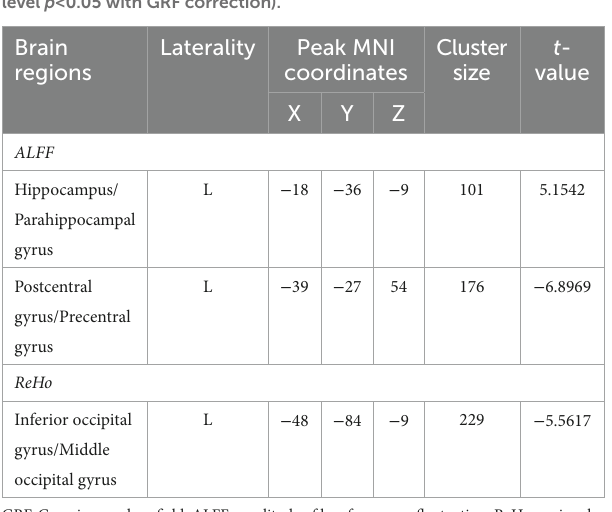
CA, cardiac arrest; HC, healthy control; MoCA, Montreal Cognitive Assessment.